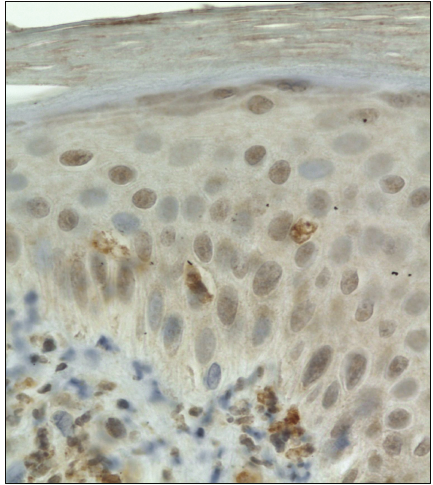
Figure 4: TRAIL immunoexpression in the cytoplasm of ker- atinocytes and inflammatory cells, (score 1),